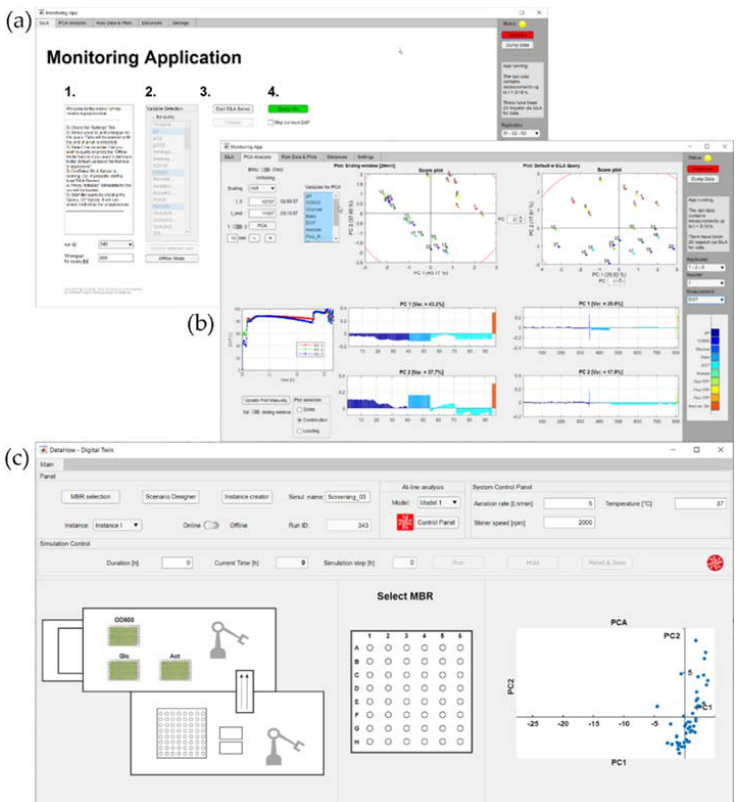
Figure 1. Screenshots of the monitoring application. Screenshot ( a ) depicts the landing page where the user selects an experiment, adapts settings, and starts the data query and subsequent online data analysis; ( b ) shows the main panel with plots for process data and results from the PCA; and ( c ) depicts the central control app of the digital twin (DTW) of the process. It allows for fast process monitoring via direct control and observation of single MBRs as well as fast identification of process failures based on PCA.